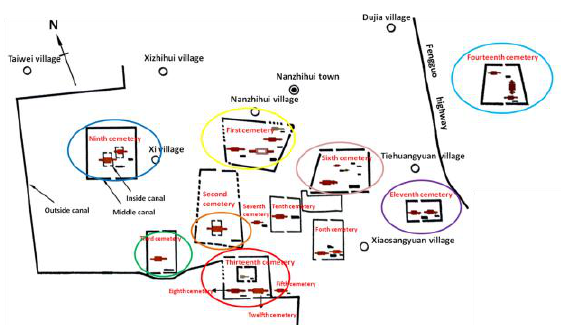
Figure 7. Potential sites candidate targets